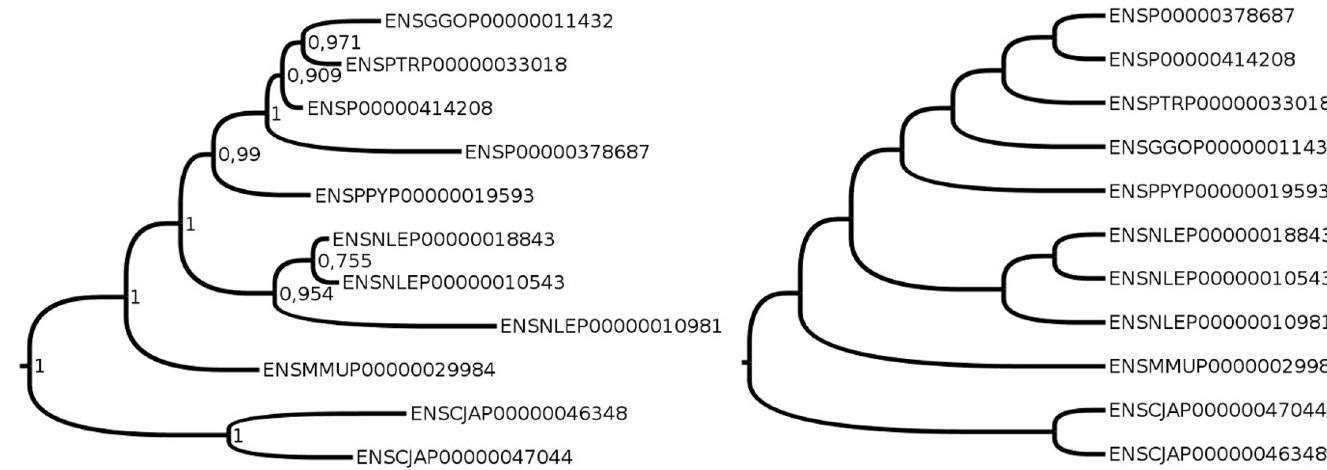
Fig 8. A probable example of ILS visible on a subtree of an Ensembl gene family. The monophyly of the chimpanzee and gorilla genes (ENSPTRP00000033018 and ENSGGOP00000011432) is well supported by the sequences (left tree, constructed by PhyML, with aLRT supports), while synteny argues for orthology of both with the human genes (ENSP00000414208 and ENSP00000378687) (right tree, constructed by ProfileNJ followed by ParalogyCorrector), so that a scenario of duplications and losses compatible with the left tree is